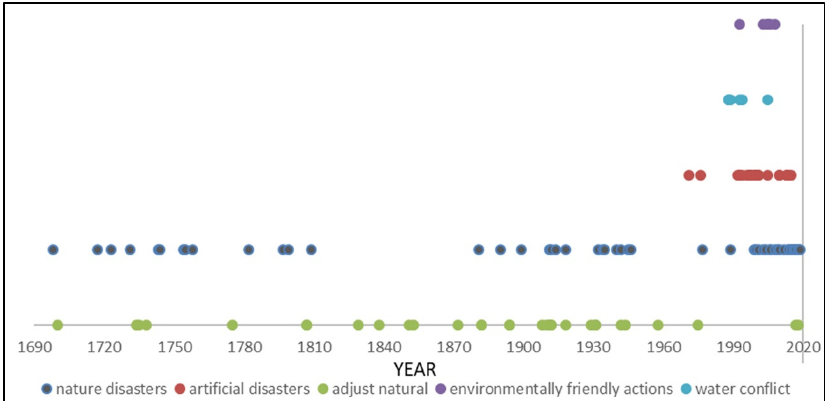
Figure 3. Number and time of water events (1680–2020).